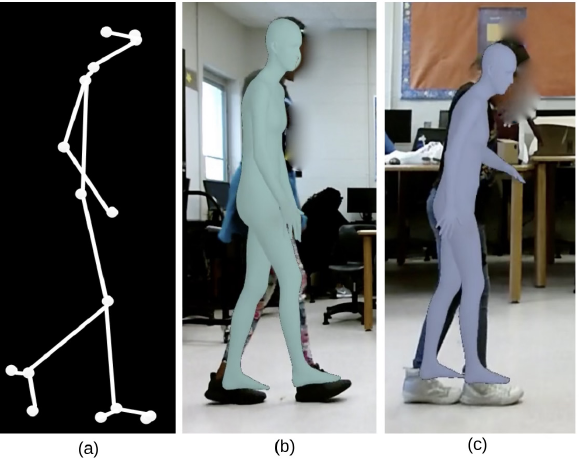
Figure 6. Example of tandem gait task: ( a ) skeleton key points, ( b ) an invalid step, ( c ) a valid step. In a valid step, the heal of the foot moving forward is expected to touch the toes of the leg behind.